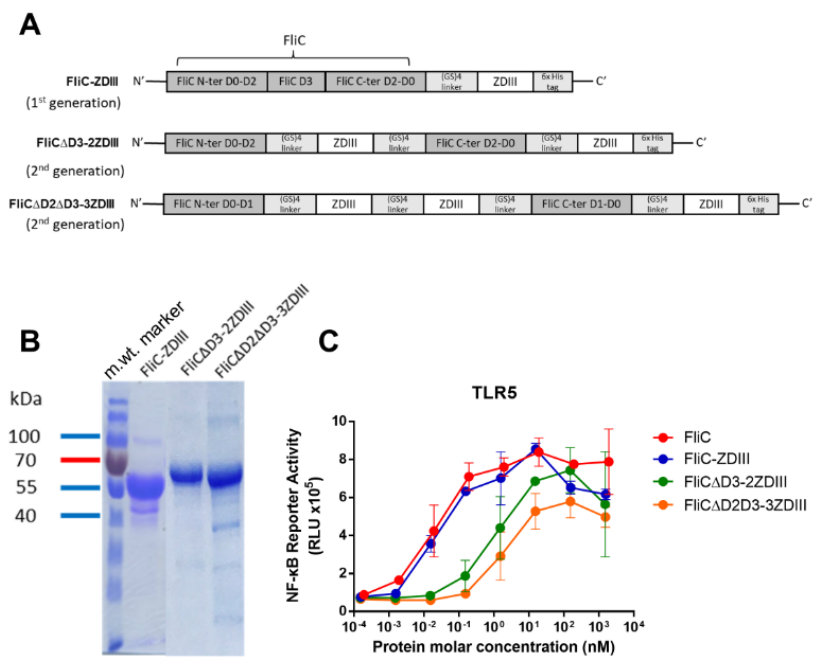
Figure 5. Expression and characterization of second ‐ generation FliC Δ D3 ‐ 2ZDIII and FliC Δ D2 Δ D3 ‐ 3ZDIII antigens. ( A ) FliC Δ D3 ‐ 2ZDIII and FliC Δ D2 Δ D3 ‐ 3ZDIII were cloned into the pET ‐ 22b (+) vector for second ‐ generation antigen expression; ( B ) FliC Δ D3 ‐ 2ZDIII and FliC Δ D2 Δ D3 ‐ 3ZDIII were produced by E. coli and purified using nickel ‐ chelated affinity chromatography. Puri ‐ fied proteins were verified by SDS ‐ PAGE staining with Coomassie blue. The color ladder is a mo ‐ lecular weight marker; ( C ) TLR5 functionality in recombinant FliC Δ D3 ‐ 2ZDIII and FliC Δ D2 Δ D3 ‐ 3ZDIII proteins were confirmed using the TLR5 assay. Error bars are plotted as standard deviation from the mean